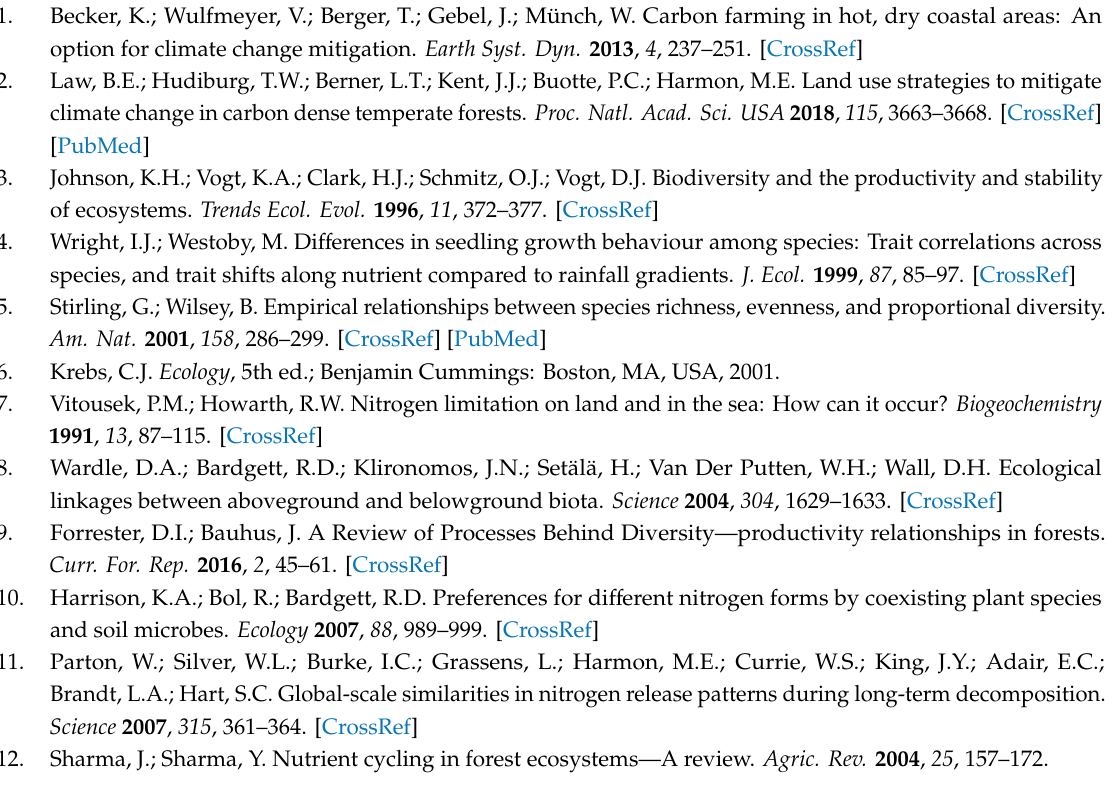
Figure S1: Phosphorous content in the soil from the nine sites surveyed for soil samples, Table S1: Proportion of basal area (relative to the total basal area of each site) for each species present in the field 24 sites, Table S2: Summary statistics of key characteristics within each of the 24 field sites surveyed, Table S3: Data on soil nutrient availability from the soil samples taken from each of the subset of nine sites that were subject to soil profiling, Table S4: Data on soil nutrient mineralisation from the soil samples taken from each of the nine soil-sampling sites. Abbreviations given in the